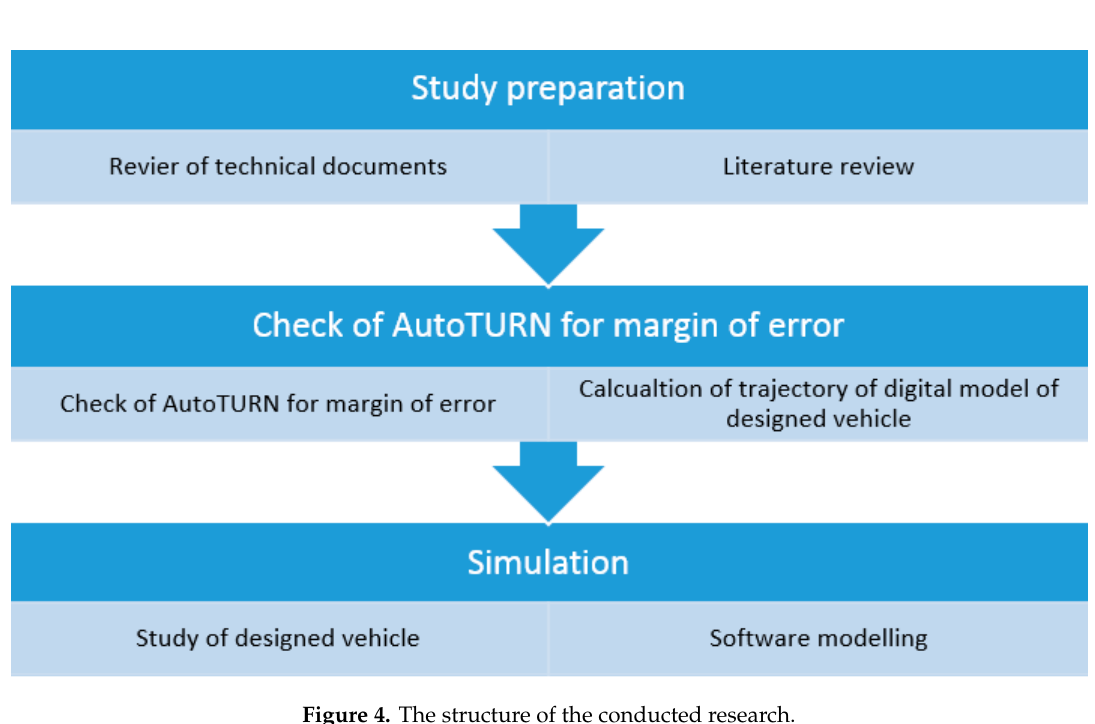
Figure 6. The layout of points O, B and C on the truck. At point O, a GPS-702GG sensor was located, which determined the trajectory of the truck. G3Ant-3AT1 sensors were located at points B and C, which made it possible to measure the angle of the sensor in relation to the GPS-702GG sensor, i.e., at point O. Thus, the authors were aware of the location of the coordinates of point O, the angle of the body position Φ 1 and Φ 2 , while the distances